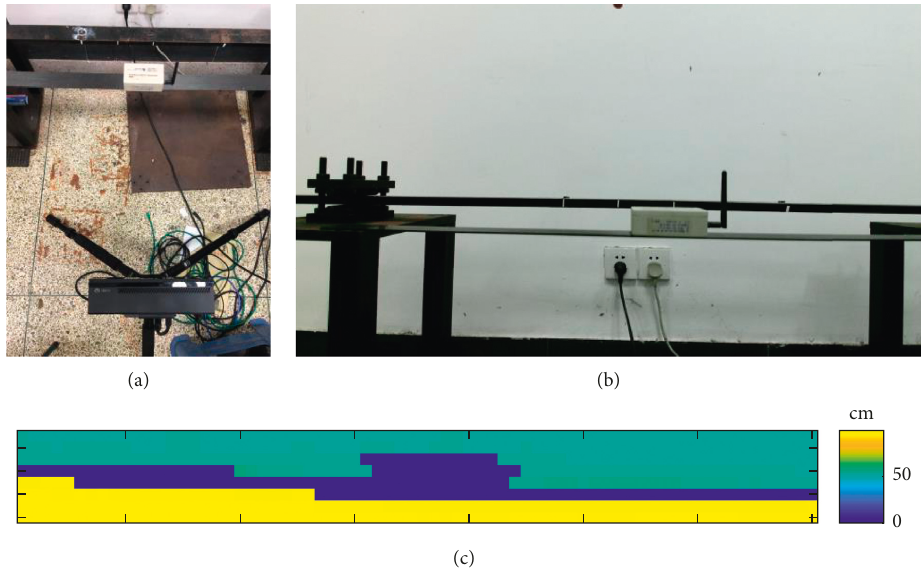
Figure 12: Simply supported carbon plate experimental setup for case 2. (a) Vibrometer placed at the midpoint of the carbon plate, Kinect pointing in a direction perpendicular to the direction of vibration. (b) Field of view (FOV) of Kinect in the RGB image. (c) ROI raw depth information